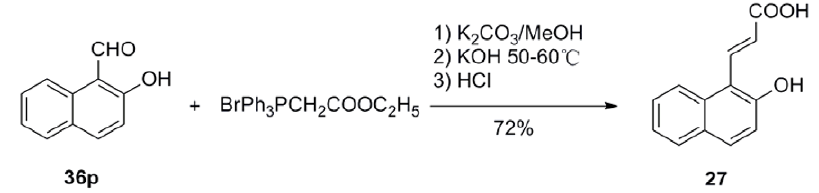
Figure 6. Synthesis of trans -3-(2-hydroxyl-1-naphthyl)acrylic acid (27).